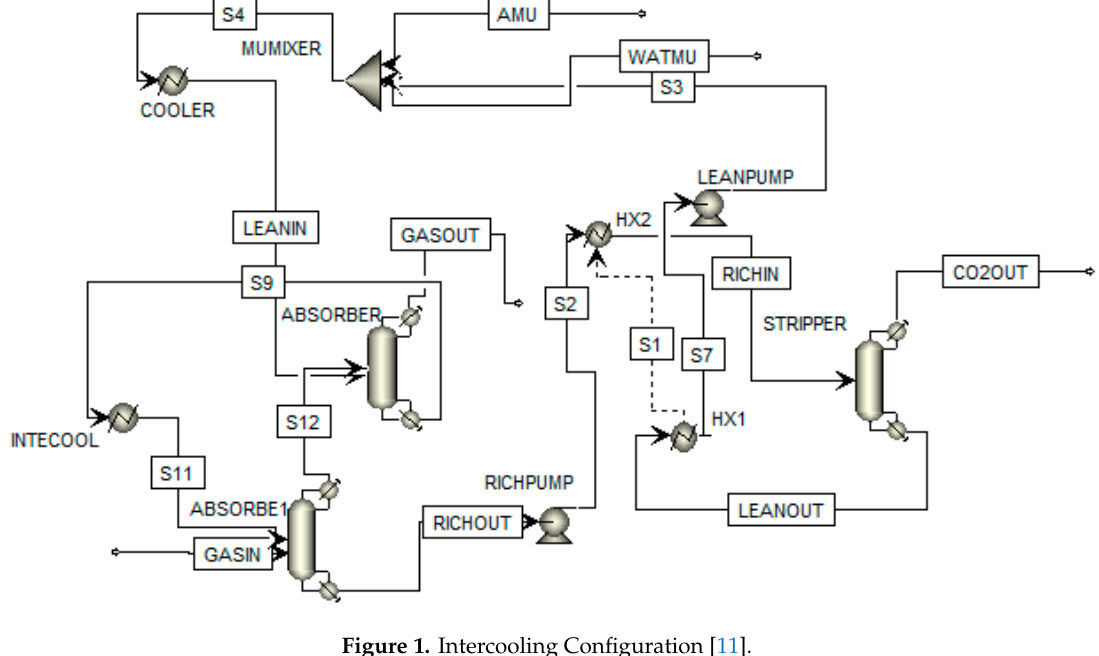
Figure 1. Intercooling Configuration [11]. Figure 1: Intercooling Configuration [11] Table 3. Results for intercooling